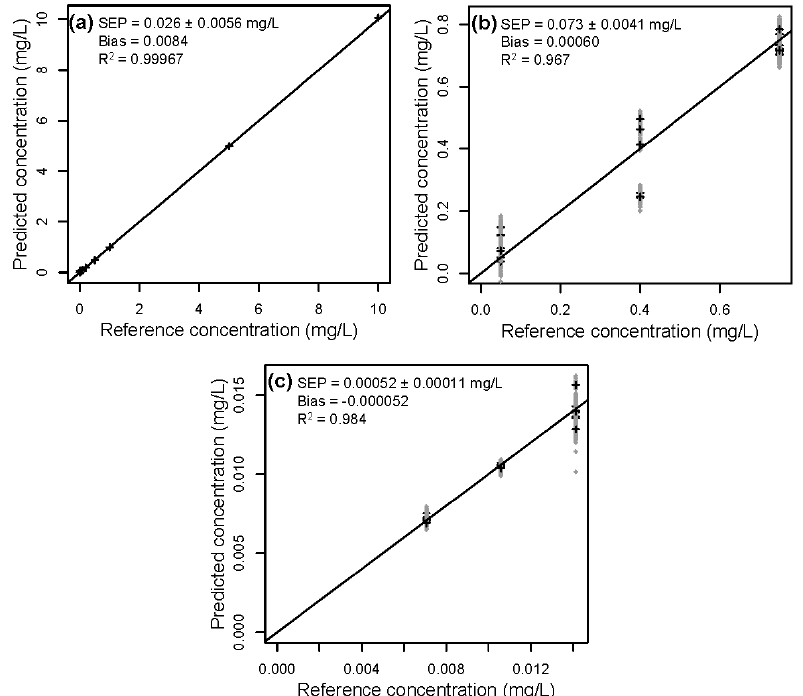
Figure 5. Reference vs. predicted concentrations of HMF in ( a ) block 1, ( b ) block 2, and ( c ) block 3 obtained by rdCV. In gray are the results from the 50 repetitions in rdCV (very close together and therefore mostly hidden), and in black are the means of 50 predictions.